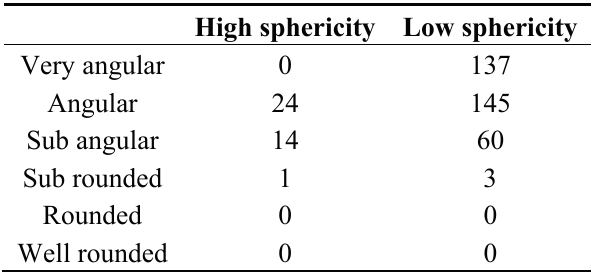
Table C3. Roundness of 384 particles from four samples: P11, P24, P31A, and P34. The roundness of a particle depends on the sharpness of the edges and corners rather than the shape